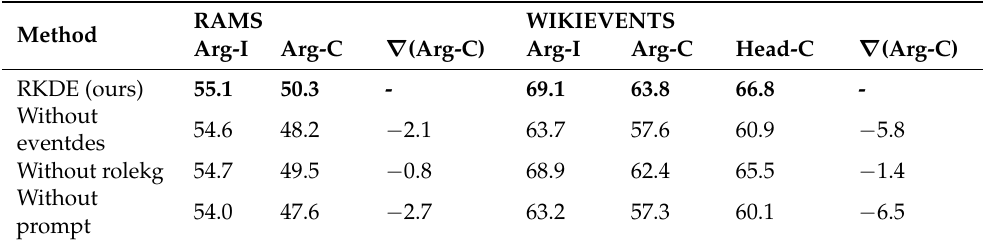
Table 3. Ablation experiments, with main results on RAMS and WIKIEVENTS (F1 score (%)).